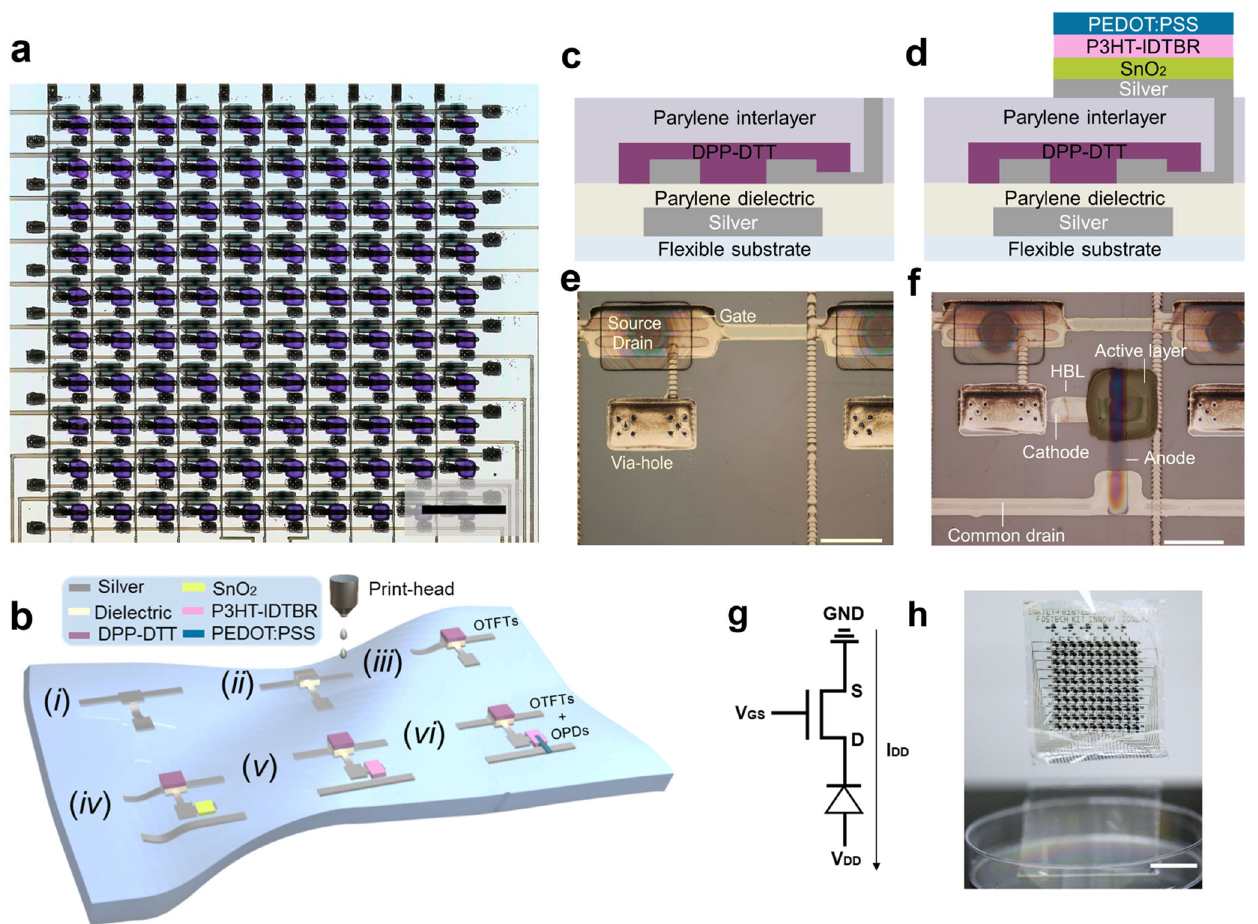
Fig. 1 Integration, design, and fabrication. a Layout of the 10 × 10 active-matrix array (scale bar = 5 mm). b Schematic of the fabrication process for the monolithic integration of inkjet-printed OTFTs and inkjet-printed OPDs on a single and fl exible substrate. c Schematic diagram of a material stack of the OTFTs. d Schematic diagram of a material stack of the OTFTs plus OPDs. The connection between both devices is achieved through a via-hole. e Microscope images of the inkjet-printed devices for OTFT alone (scale bar = 1000 µm). f Microscope images of the inkjet-printed devices for OTFT plus OPD (scale bar = 1000 µm). g Schematic of the electric circuit. The OTFT and OPD devices are connected in series. h Photograph of fi nal active-matrix sample on ultrathin (<5 µm) fl exible substrate (scale bar = 20